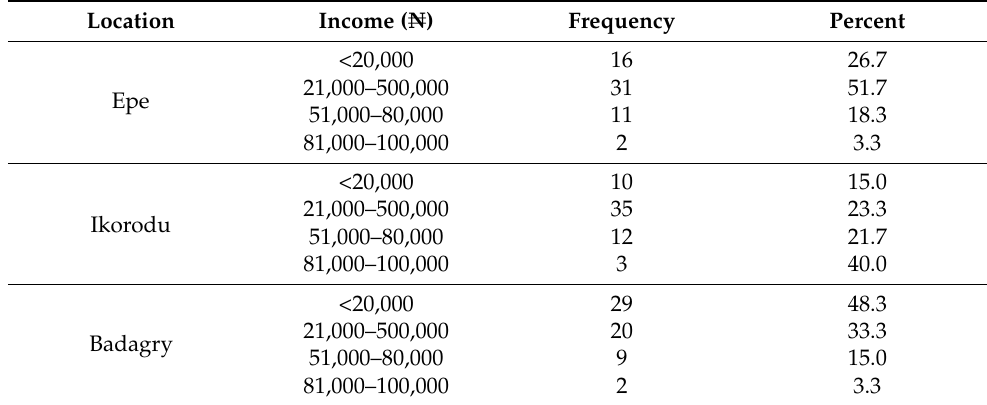
Table 4. Income class for the survey respondents.